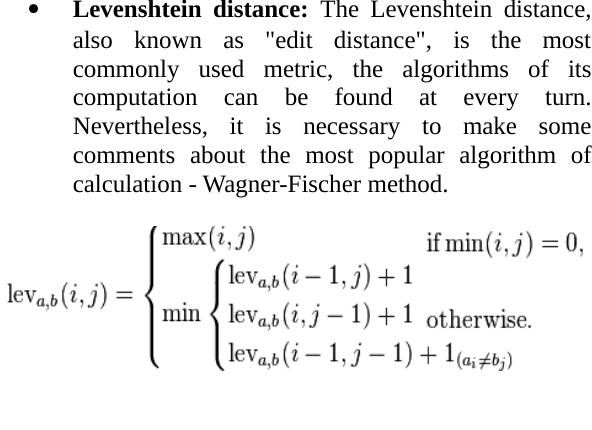
Figure 2 . Levenshtein Distance formula